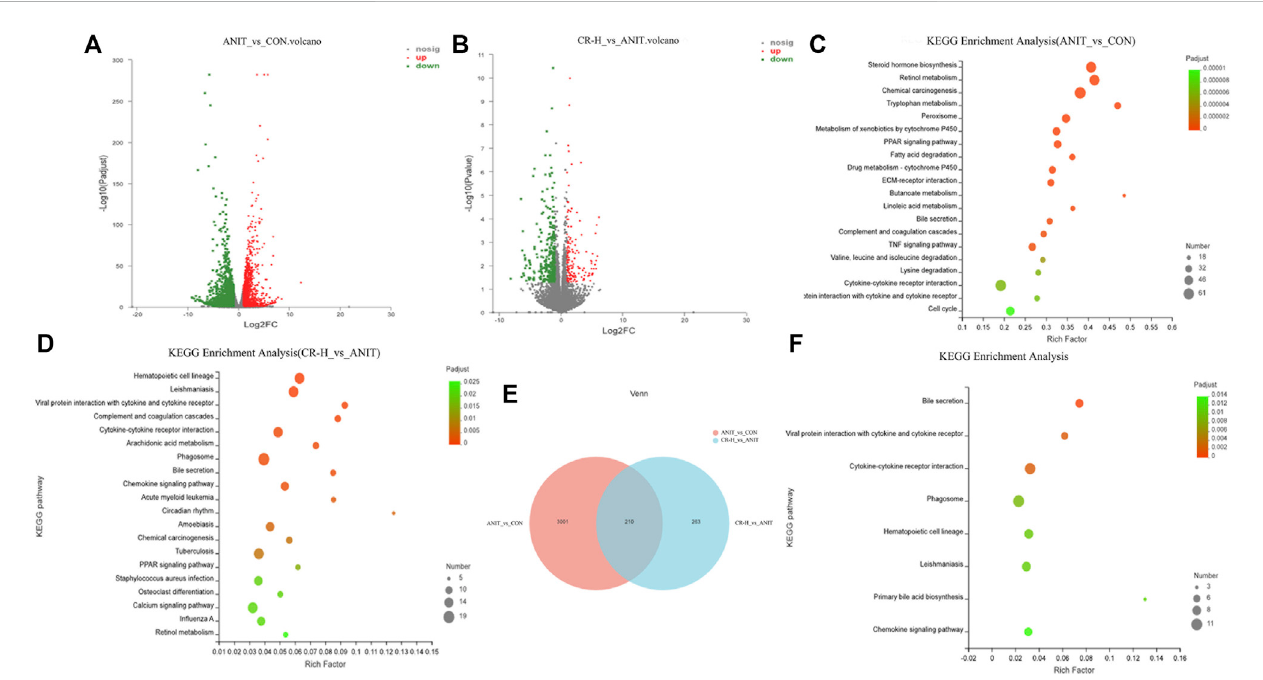
FIGURE 7 Transcriptomic data analysis (CON, ANIT, and CR-H groups; n = 3). (A, B) Volcano map of between-group DEGs; (C) the KEGG pathway analysis of the ANIT and CON groups; (D) the KEGG pathway analysis of the CR-H and ANIT groups; (E) the Venn diagram of DEGs among groups; (F) the KEGG pathway analysis of 210 DEGs.